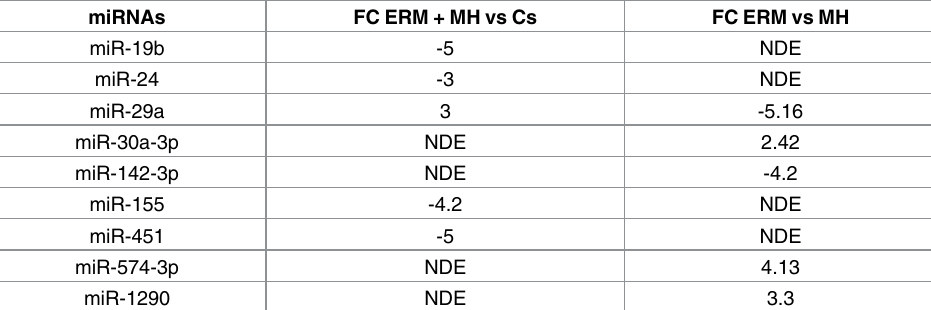
Table 1. Nine differentially expressedmiRNAs.